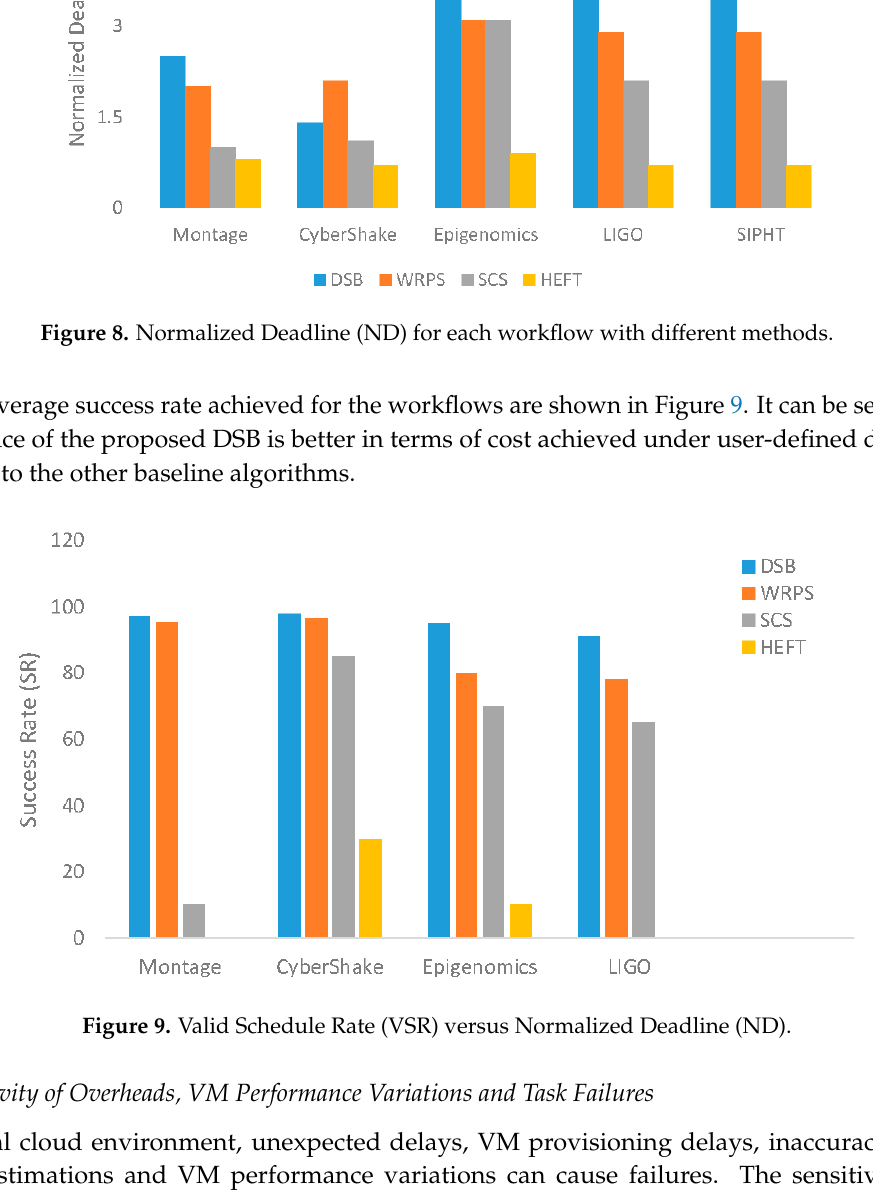
Figure 10. Sensitivity to inaccurate estimations and task execution failure. 5.5. Analysis of Variance (ANOVA) Test In this section, the statistical significance of the obtained experimental results is checked by the one ‐ way ANOVA test [35]. Table 4 shows that most of the variation in the obtained results is the variation between and not the variation within. It is evident that the ANOVA test is statistically